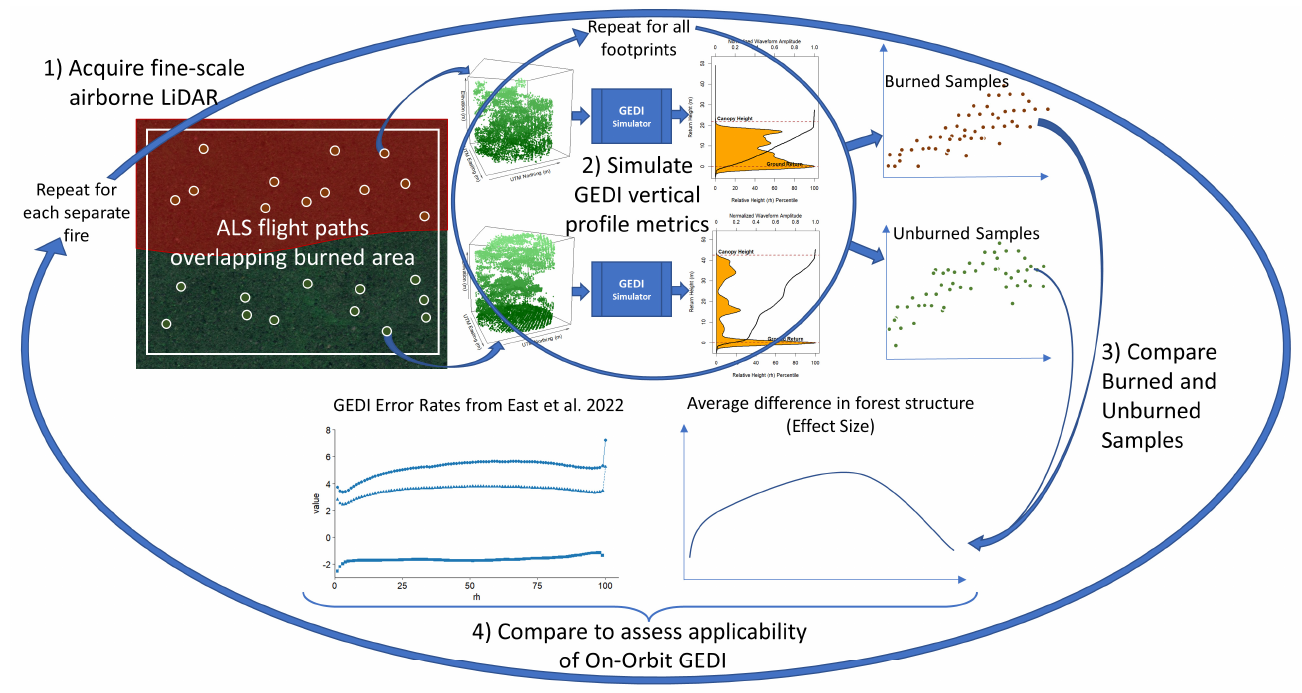
Figure 1. Workflow for data processing and conceptual basis for comparison between burned and unburned forest and between results from simulated GEDI data with regional GEDI accuracy.